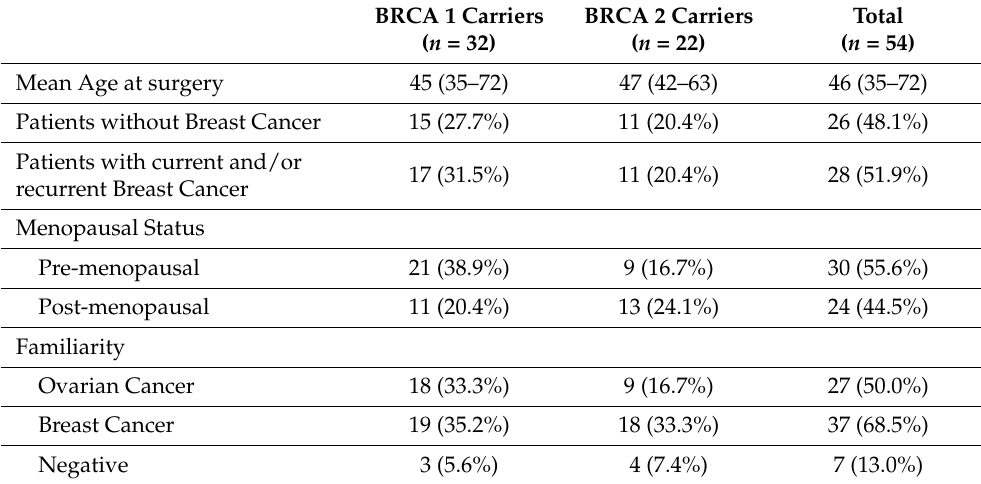
Table 1. Patients general